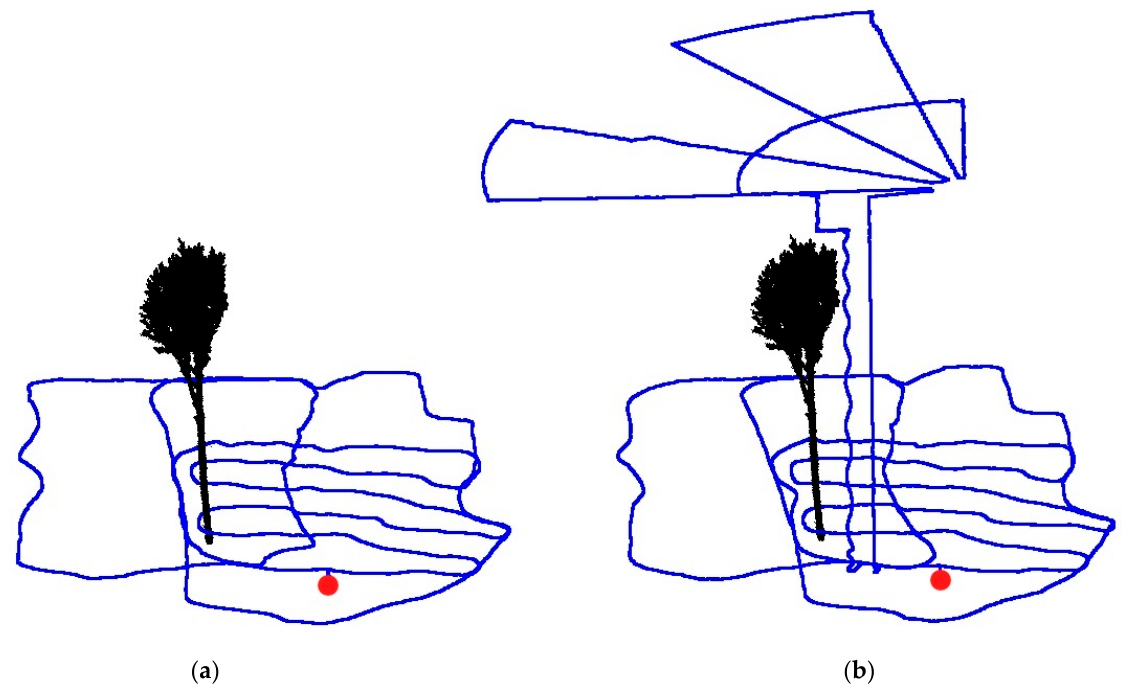
Figure 2. The walking paths (blue lines) for the beech plot for the two scan conditions, ( a ) ground scan and ( b ) full scan. The red dot indicates the same starting point in each scan. The walking path on the ground is identical. A beech tree is shown as an example for better orientation.